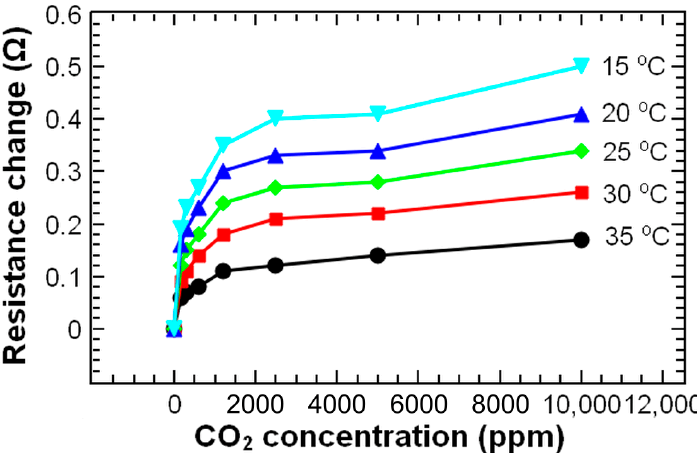
Figure 5. Resistance change at a steady state, Δ R S , as a function of CO 2 concentration at different temperatures.